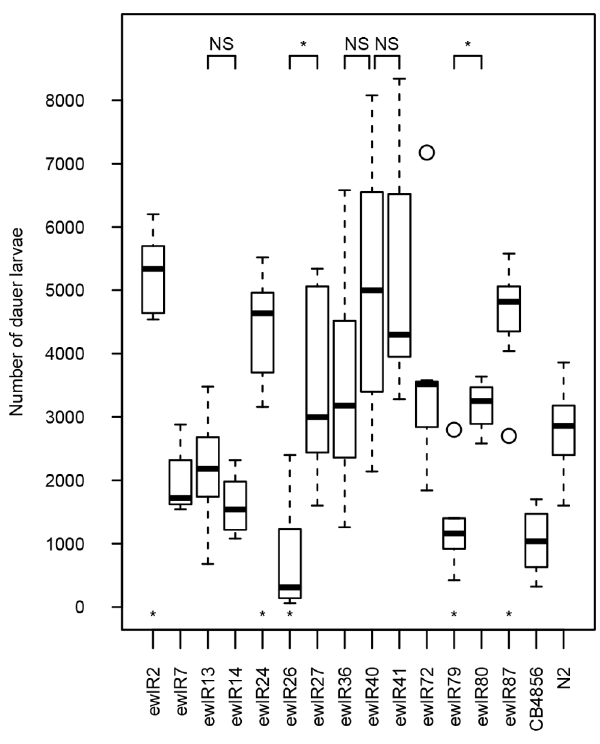
Figure 2. Introgression lines vary in the number of dauer larvae present a week after food exhaustion. Box and whisker plots of the number of dauer larvae present a week after exhaustion of 100 m l of 20% w/v food in N2, CB4856 and in ILs containing both positive and negative effect QTLs. CB4856 is shown only as a reference. ILs that differed from N2 are indicated by asterisks above the line names ( p , 0.05, post hoc Mann-Whitney U-tests). IL versus IL comparisons are shown at the top of the figure, with asterisks denoting significant differences between ILs tested ( p , 0.05, Mann-Whitney U-tests with a Bonferroni adjustment to correct for multiple testing), comparisons where the ILs do not differ are labelled NS.